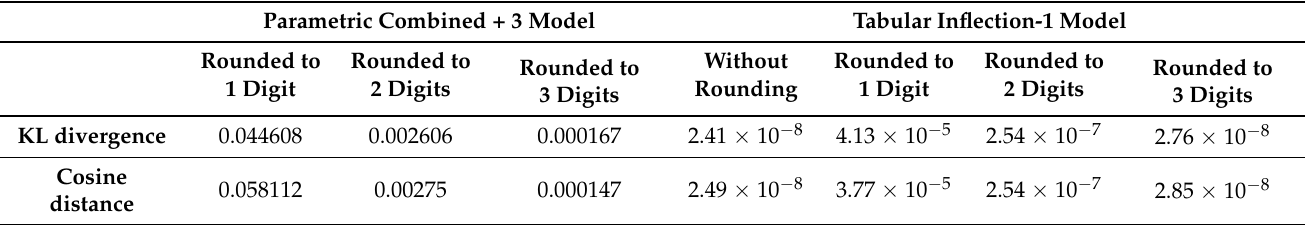
Table 5. KL divergence and cosine